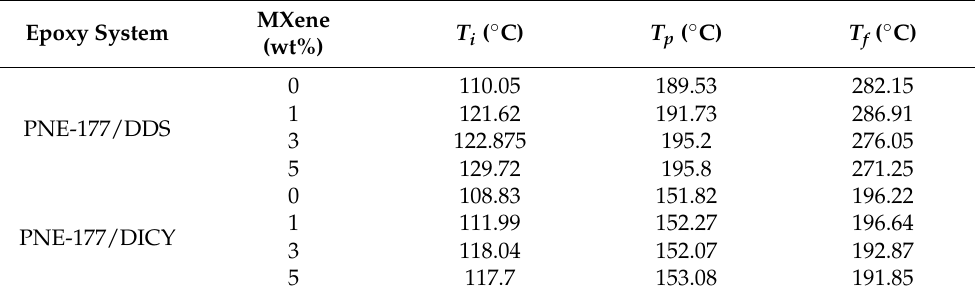
Table 2. The extrapolated characteristic temperatures of different MXene-doped PNE-177/DDS and PNE-177/DICY systems.